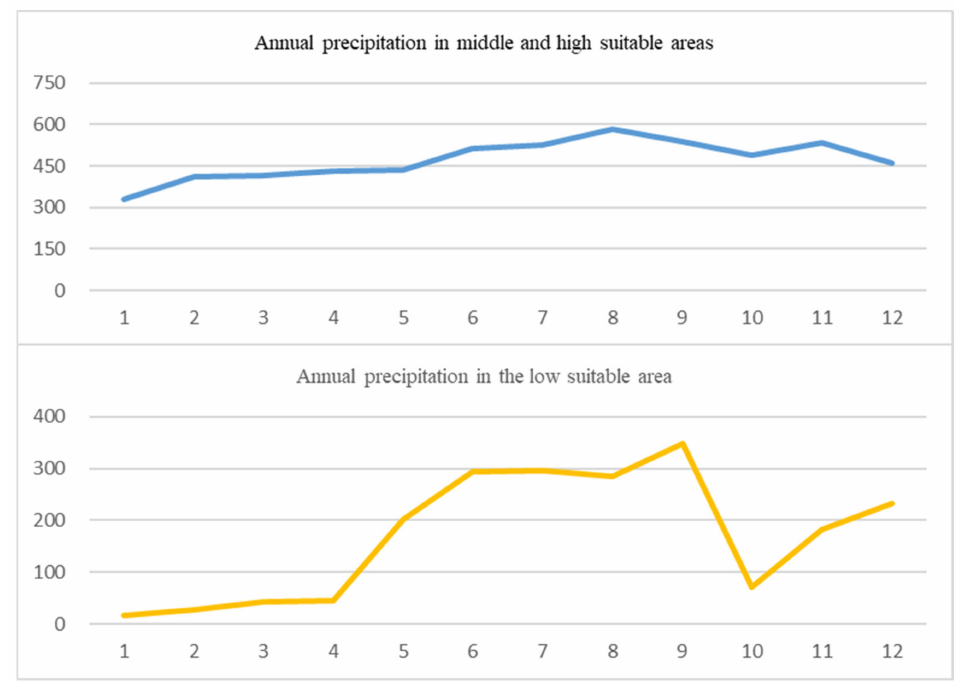
Figure 6. Precipitation of 24 observation points in the middle- and high-suitability area and low- suitability area of the Qinghai–Tibet Plateau from 1952 to 2016. Blue represents the annual pre- cipitation in medium- and high-suitability areas, Orange represents the annual precipitation in low-suitability